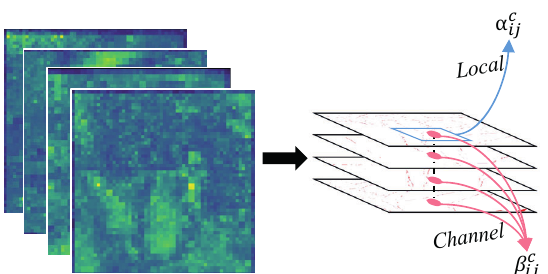
Figure 3. Keypoint detection. The keypoints are determined from the peaks in the local spatial- and channel domains. For each position ( i, j ) and channel ( c = 1 , 2 , ..., c ) in the feature map output by the detection network, the local spatial( α c ij ) and channel ( β c ij ) scores are calculated to generate the keypoint